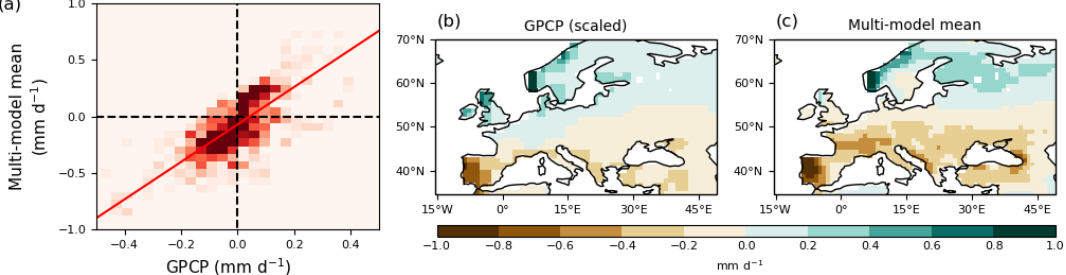
Figure 10. 2-D histogram and straight-line fit comparing the change in December to February (DJF) land precipitation rate over Europe (mmd − 1 ) from Global Precipitation Climatology Project (GPCP) observations with the multi-model mean; the GPCP data are the differences between positive and negative North Atlantic Oscillation winters over 1979–2015 and the model data are the mean differences between G6sulfur and ssp245 for 2081–2100 (a) . The difference in DJF land precipitation rate over Europe (mmd − 1 ) from GPCP as defined in panel (a) scaled by the gradient (1.65) of the straight-line fit. The multi-model mean difference in DJF land precipitation rate over Europe (mmd − 1 ) between G6sulfur and ssp245 for 2081–2100 (c)